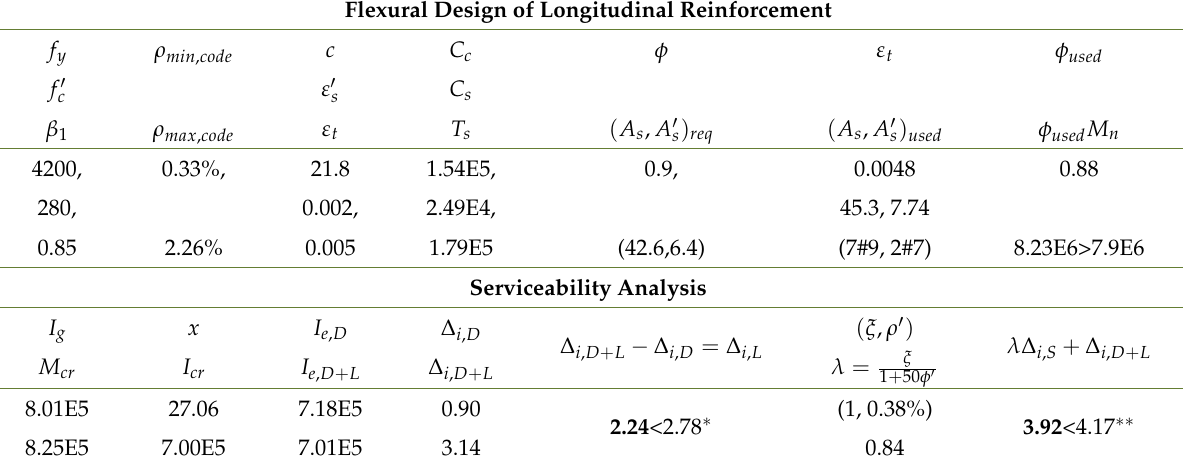
Table 3. Flexural design and serviceability analysis with f y = 4,200 kgf/cm